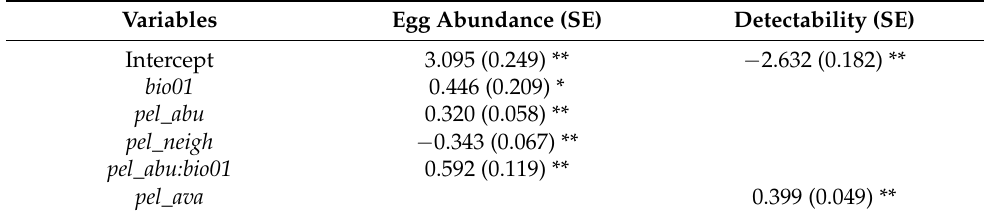
Table 3. β estimates for the best fitting N-mixture model. Variables Egg Abundance (SE) Detectability (SE)